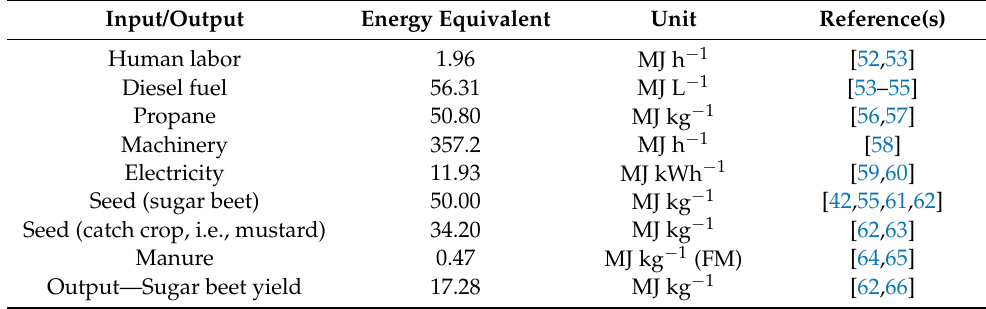
Table 1. Energy equivalents used for the calculation of energy input and